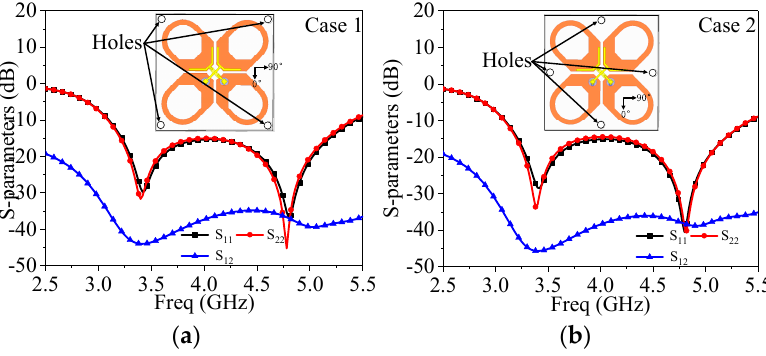
Figure 8. Two cases of trepanning. ( a ) Case 1, ( b ) case 2.